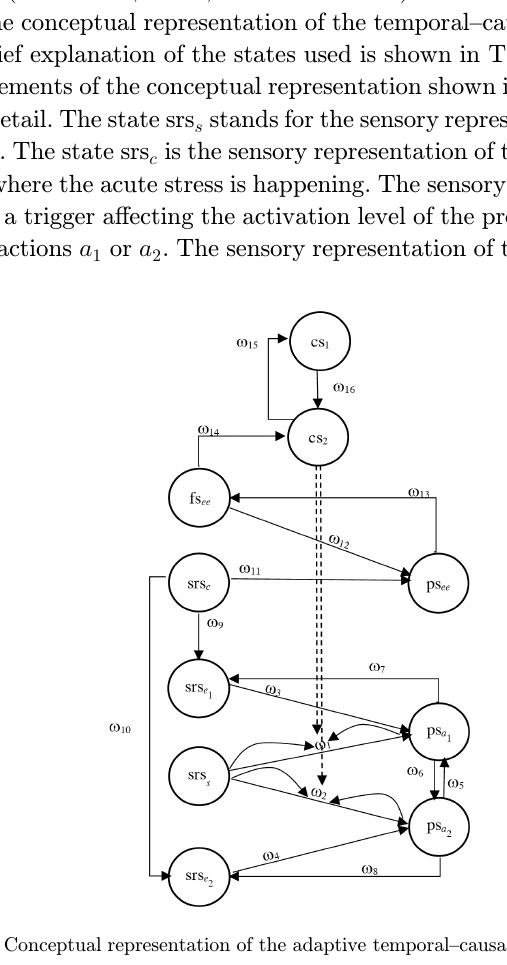
Fig. 1. Conceptual representation of the adaptive temporal – causal network